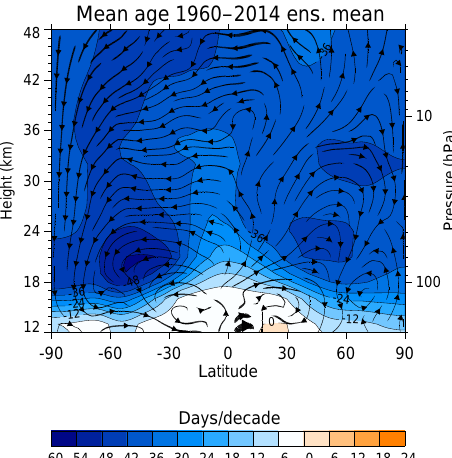
Figure 2. Trends in annual averaged BDC from 1960 to 2014 in the ensemble mean of the three all-forcing integrations. Mean age trends are indicated by contours with a contour interval of 6 daysdecade − 1 , and the residual circulation trends are indicated with streamlines. The thickness of the streamline is proportional to the magnitude of the wind